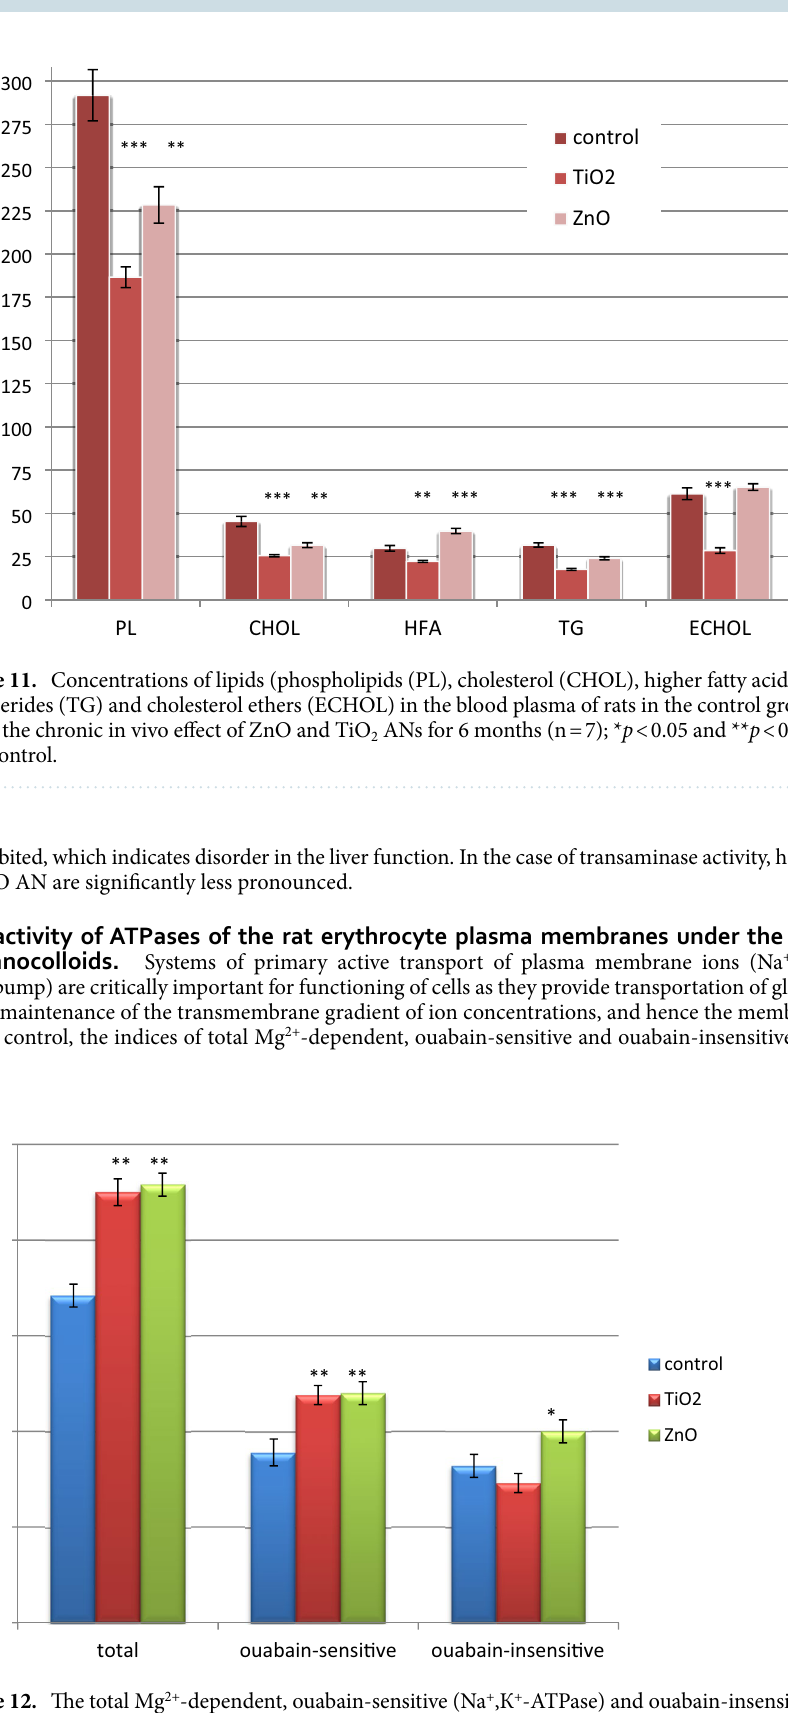
Figure 12. The total Mg 2+ -dependent, ouabain-sensitive (Na + ,К + -ATPase) and ouabain-insensitive ATPase activity of erythrocyte plasme membranes of rats in the control group (n = 7) and under the chronic in vivo effect of ZnO and TiO 2 ANs for 6 months (n = 7); * p < 0.05 and ** p < 0,001 compared with